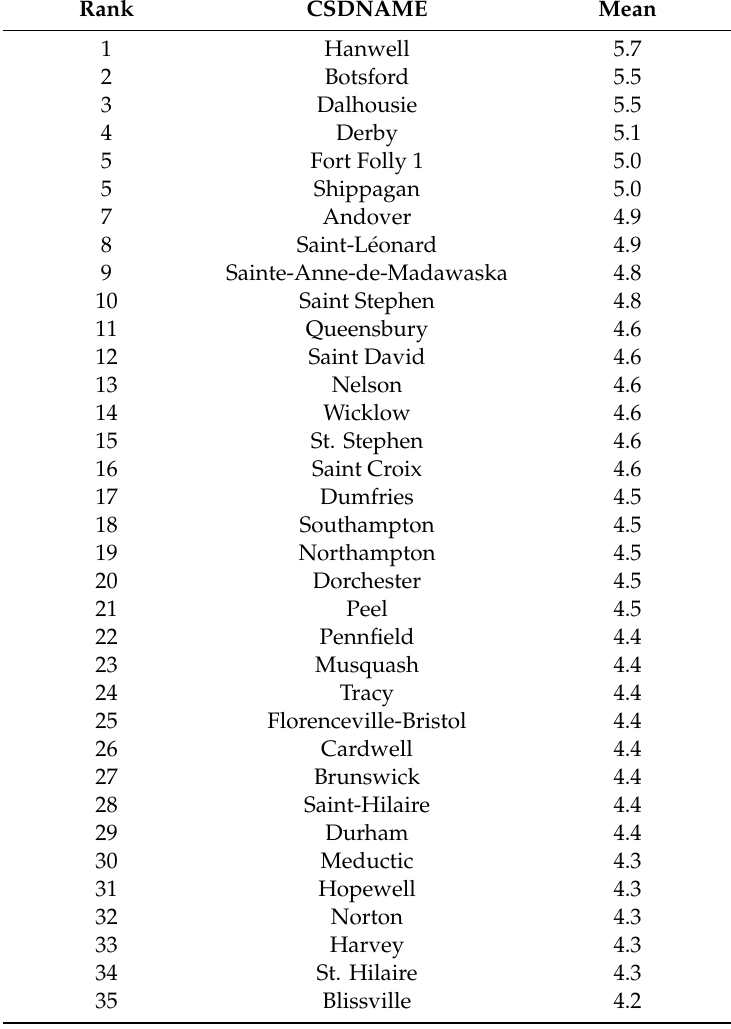
Table 7. Risk of damage from road and railway prioritization based on zonal statistics. Rank CSDNAME Mean 1